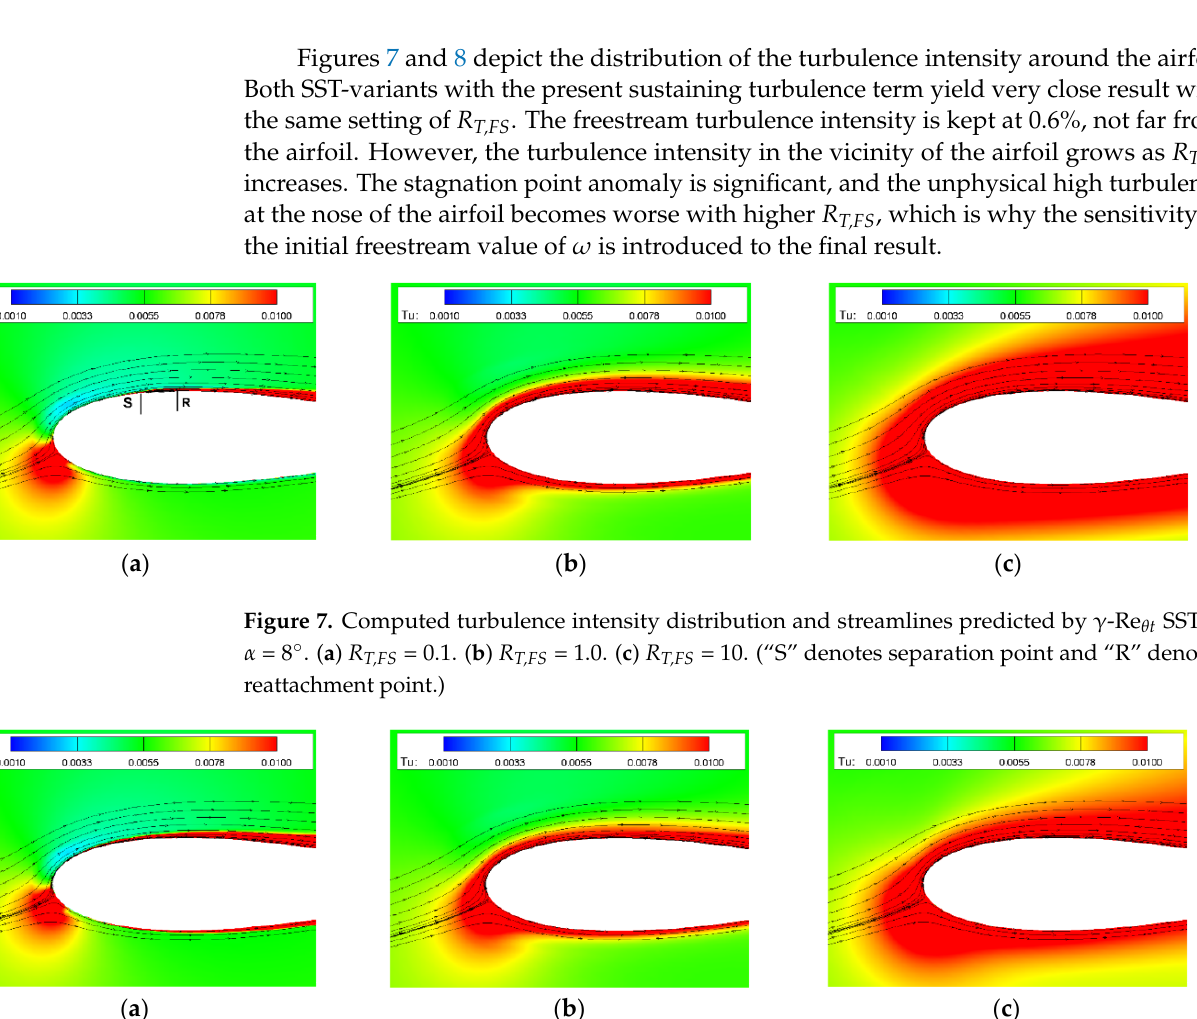
Figure 6. Computed force coefficients predicted with sustaining term from [4] and present approach using γ -Re θ t SST 2003 model. ( a ) Lift coefficient vs. AoA. ( b ) Drag coefficient vs. AoA. ( c ) Pitching moment coefficient vs. AoA.